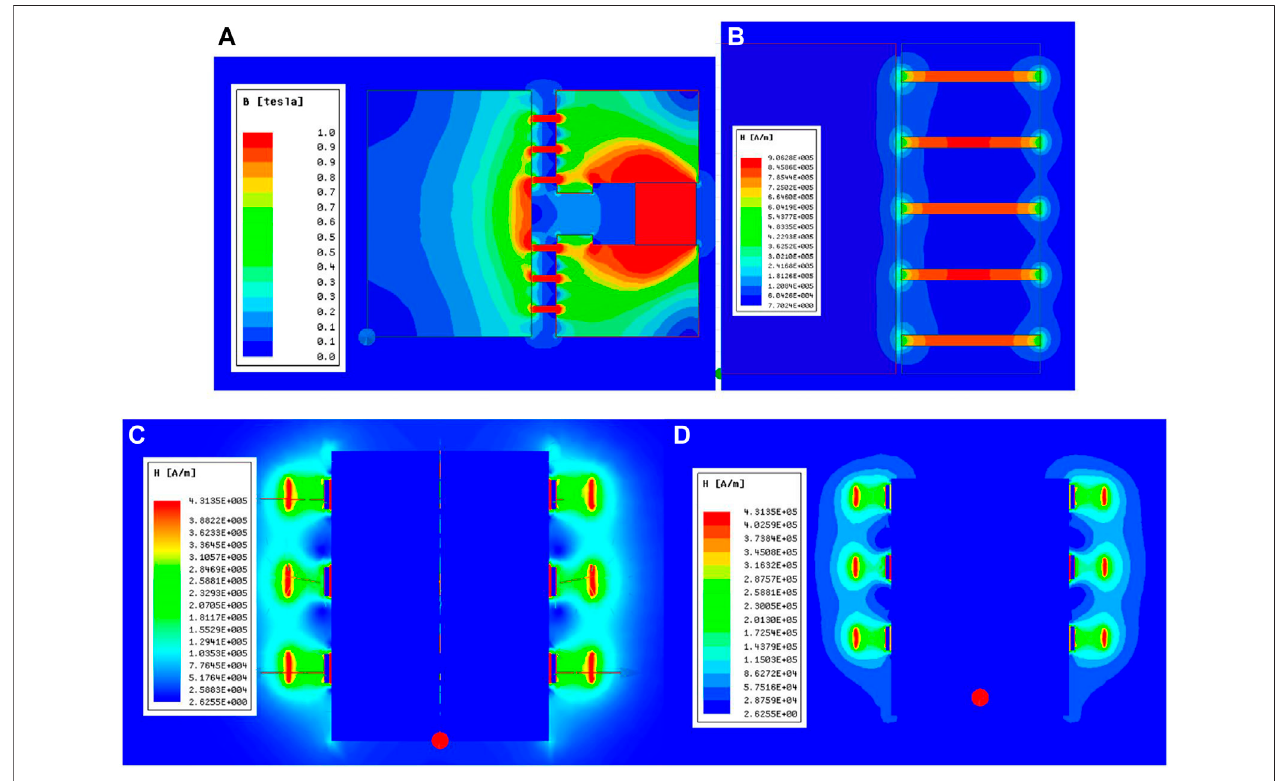
FIGURE 7 | Contour plot. (A) Classic FF seal; (B) FF radial-charged seal; (C) FF cuboid magnet seal; (D) FF cylindrical magnet